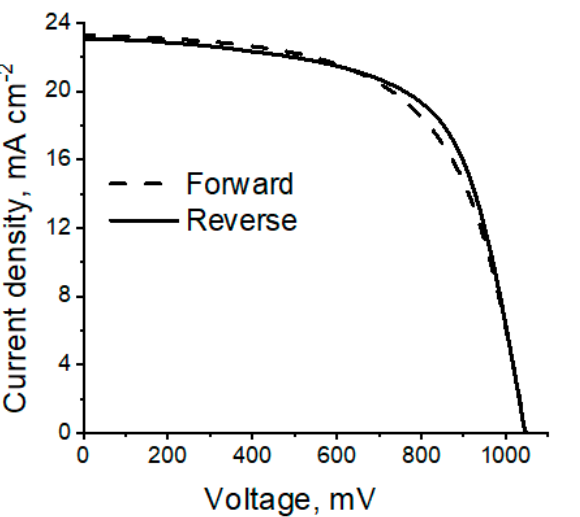
Figure 7. The current–voltage characteristics of the ITO/SnO 2 /PCBA/perovskite/PTAA/MoO 3 /Ag perovskite solar cell, where the perovskite is represented by MAPbI 3 loaded with 0.025% of NAdCl.